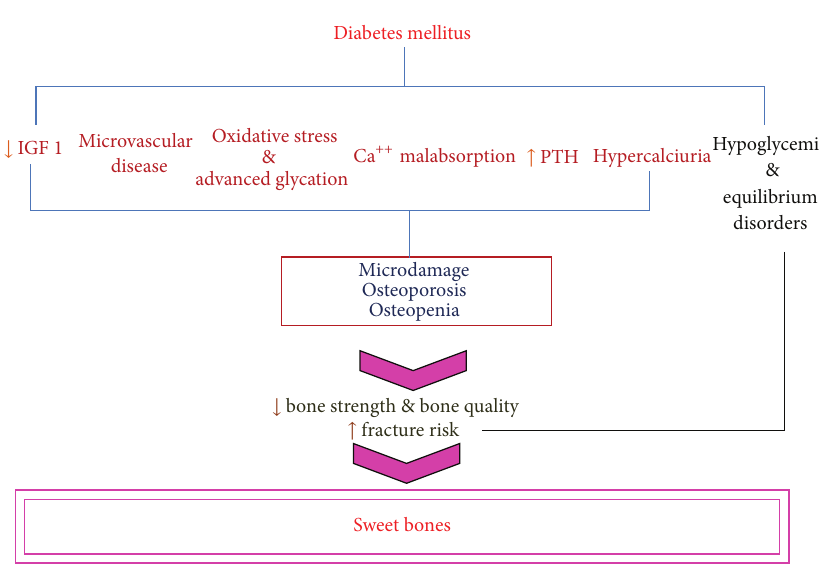
Figure 1: The pathogenesis of bone alteration in